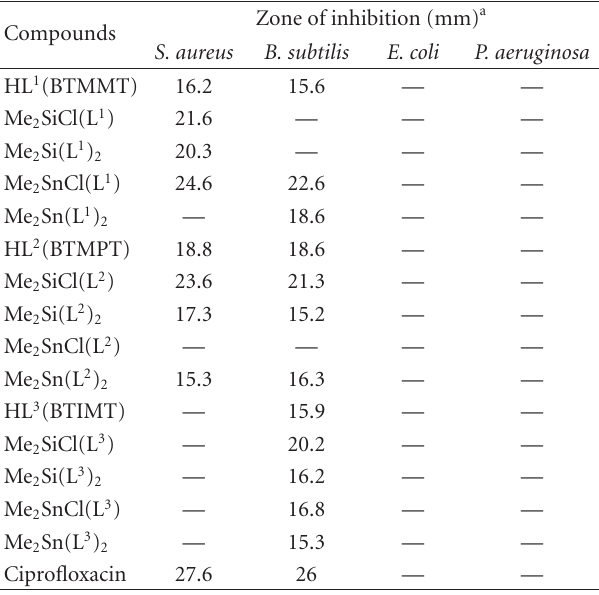
Table 7: In vitro antifungal activity of the ligands and their metal